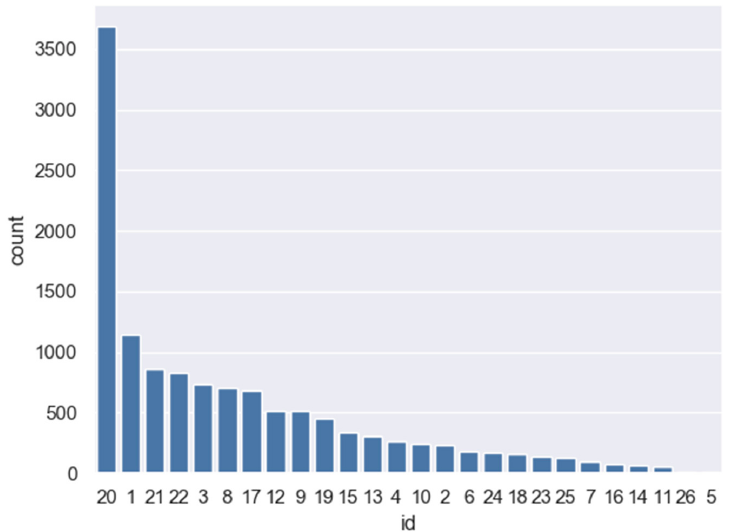
Figure 3. The number of files available for each class (individual). For training, from each class we took 900 files